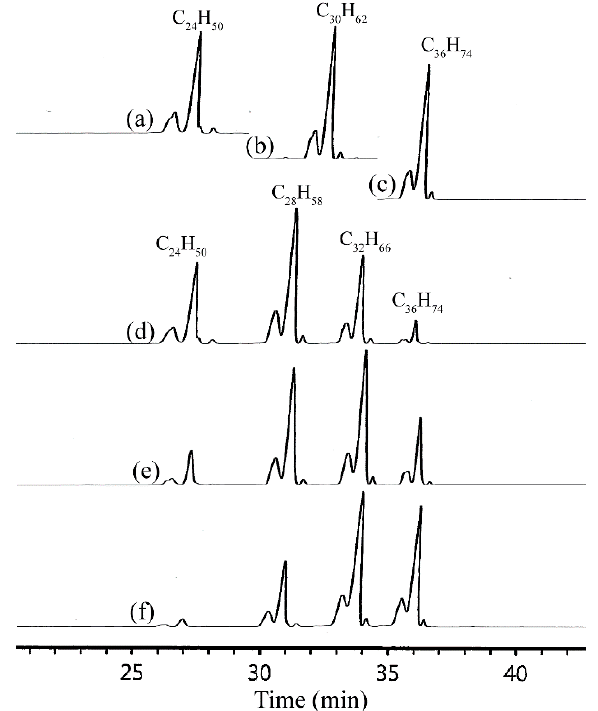
Figure 5. Simulated distillation Gas Chromatography (SimDis GC) charts for α ‐ olefin trimers prepared with ( a )1 ‐ octene, ( b ) 1 ‐ decene, and ( c ) 1 ‐ dodecene monomers, as well as 1 ‐ octene/1 ‐